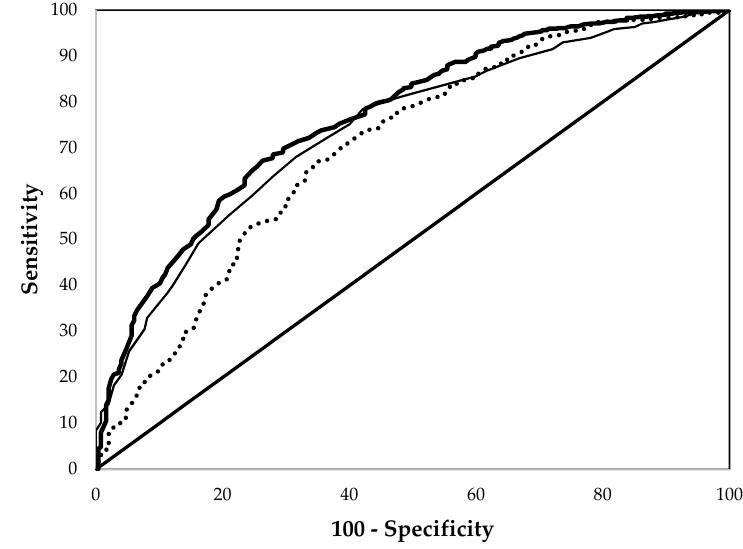
Figure 3. Comparison of the receiver operating characteristic curves of erythrocyte protoporphyrin (thick line), hemoglobin (thin line), and mean cell volume (dashed line) in detect iron deficiency for pregnant women aged 15–49 years from the National Health and Nutrition Examination Surveys 1999–2006.